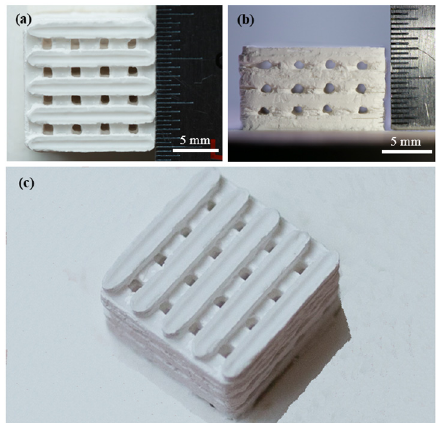
Figure 1. ( a ) Top view ( b ) side view and ( c ) isometric view of the CaSO 4 scaffolds with 5 wt % 45S5